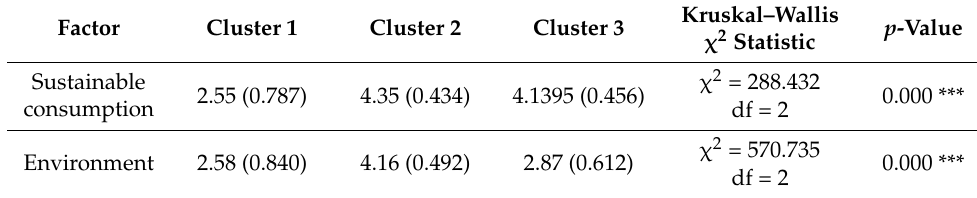
Table 4. Factors’